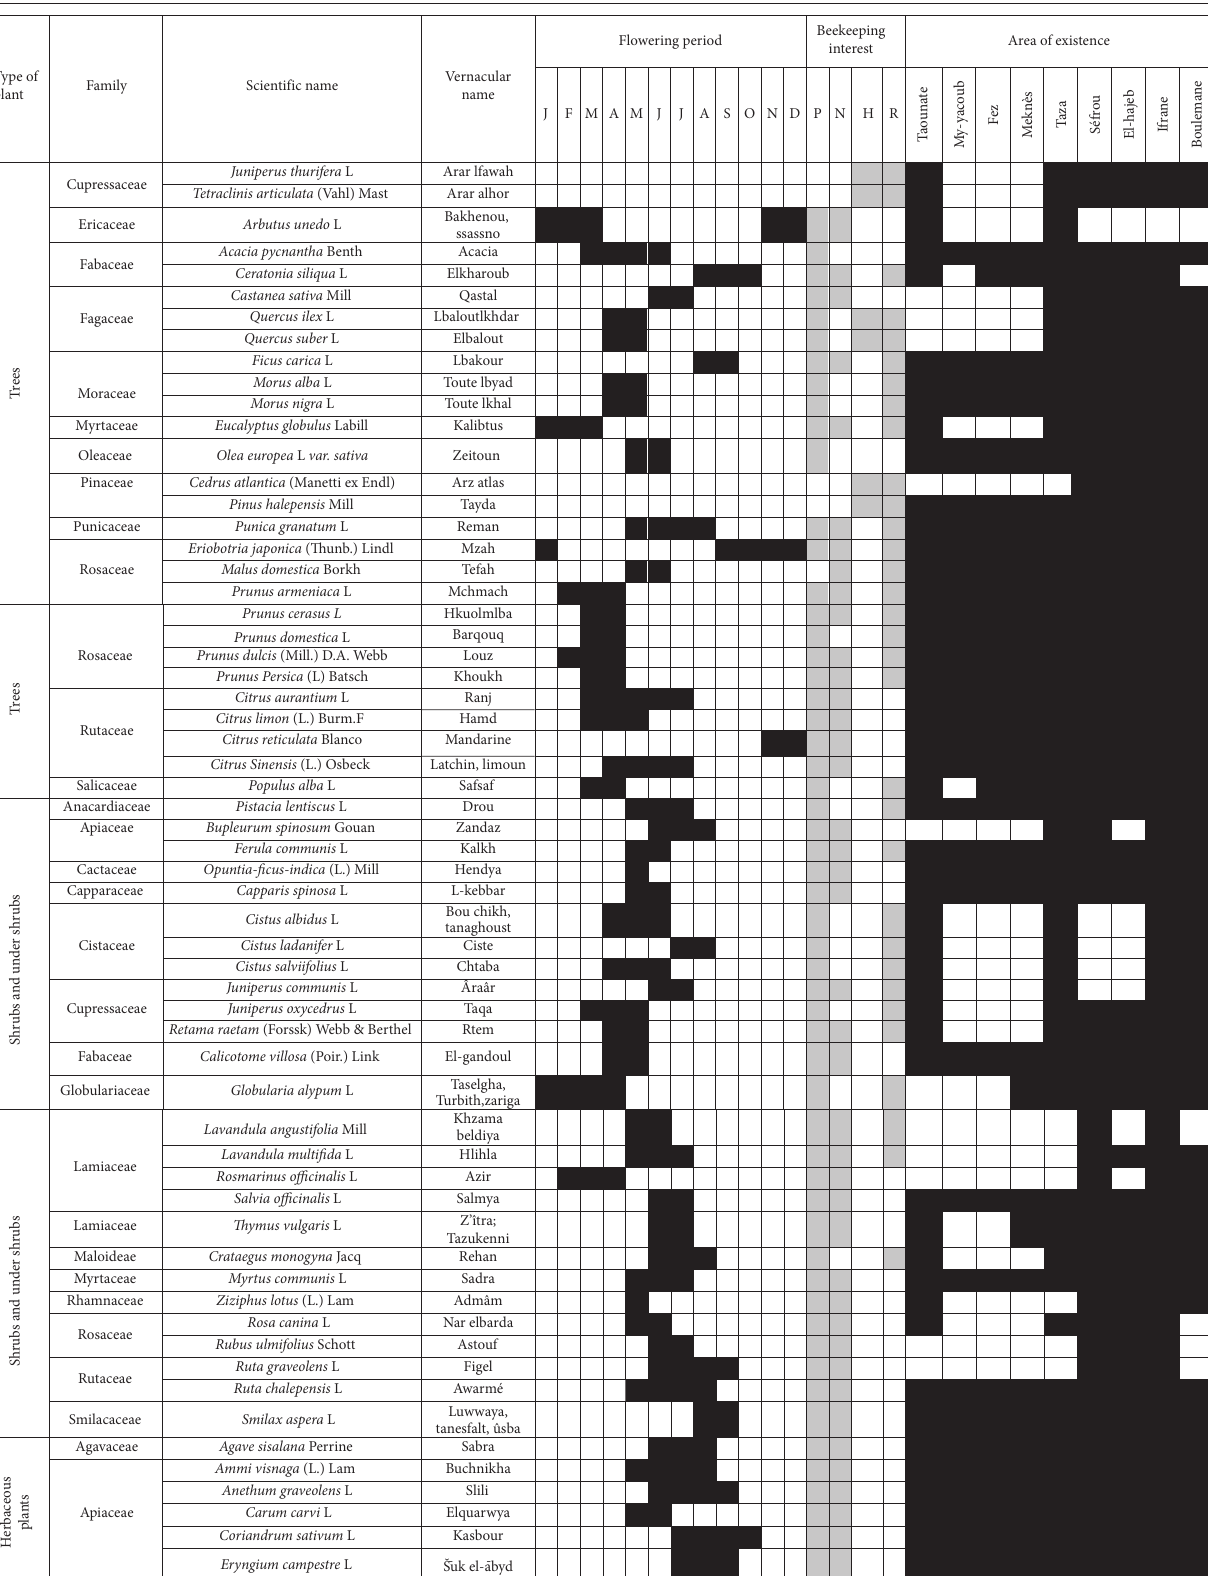
Table 3: List of melliferous plants in the Fez-Meknes